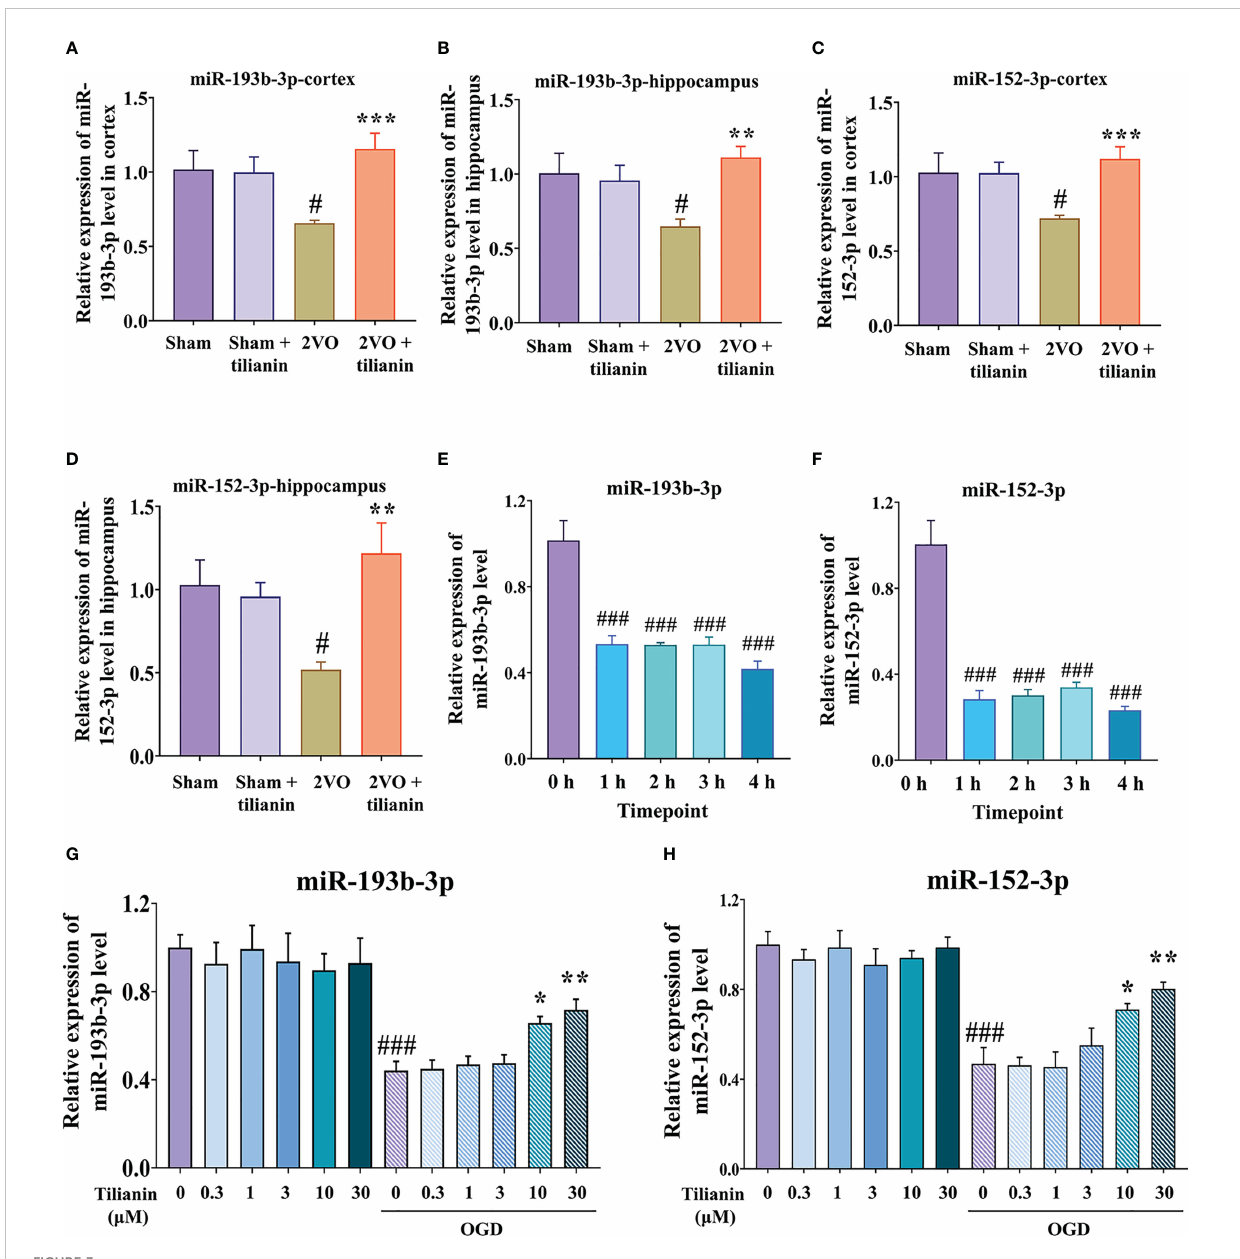
FIGURE 3 Expression of miR-193b-3p and miR-152-3p in VaD-related models. (A, B) Expression of miR-193b-3p in the cortex (A) and hippocampus (B) of 2VO rats. (C, D) Expression of miR-152-3p in the cortex (C) and hippocampus (D) of 2VO rats. (E, F) Expression of miR-193b-3p I and miR-152-3p (F) in OGD-injured cells at different time points. (G, H) Expression of miR-193b-3p (G) and miR-152-3p (H) in OGD-injured cells treated with tilianin. Results represent the mean ± SD, n =4. # P <0.05, ### P <0.001 vs. corresponding controls, * P <0.05, ** P <0.01, *** P <0.001 vs. OGD or